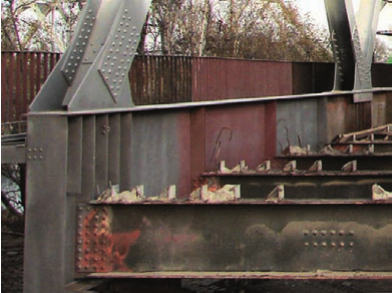
Fig. 2. Truss rigid flange of “I” cross-section during bridge refurbishment (RC slab removed); cross beam spacing is four times smaller than flange node